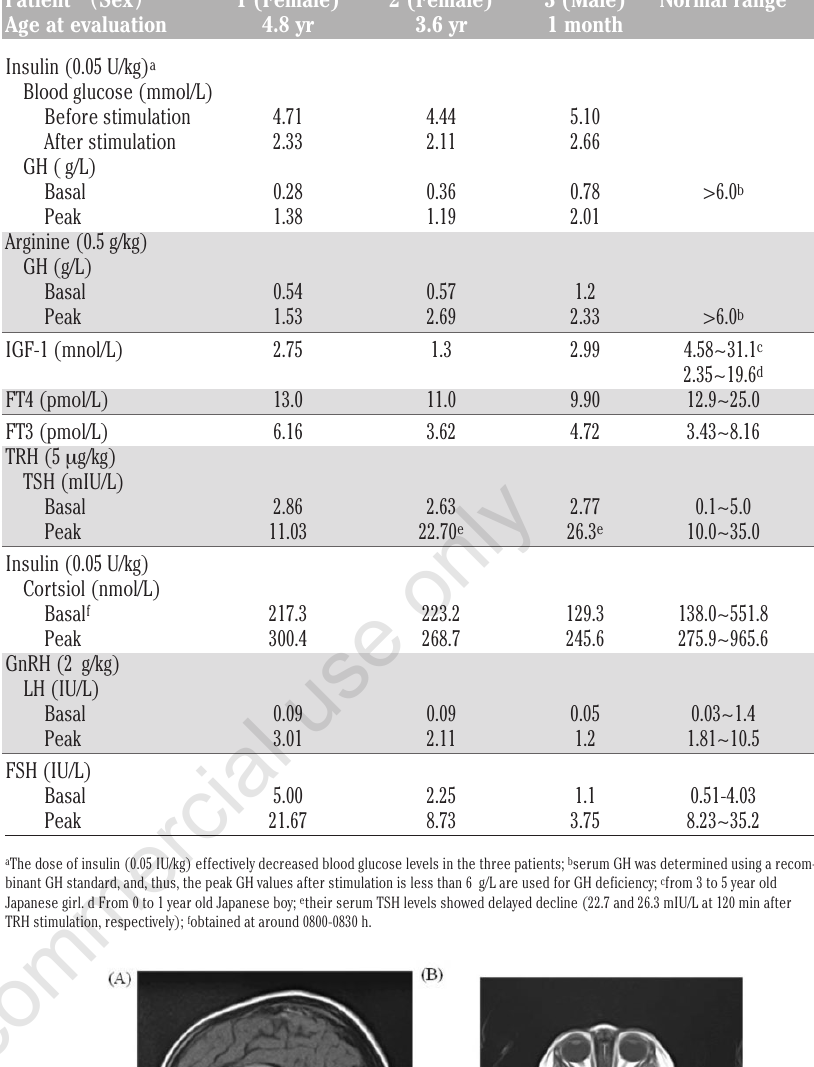
Table 1. Hormone deficiency profiles of the patients Patient （ Sex ） Normal range Age at evaluation